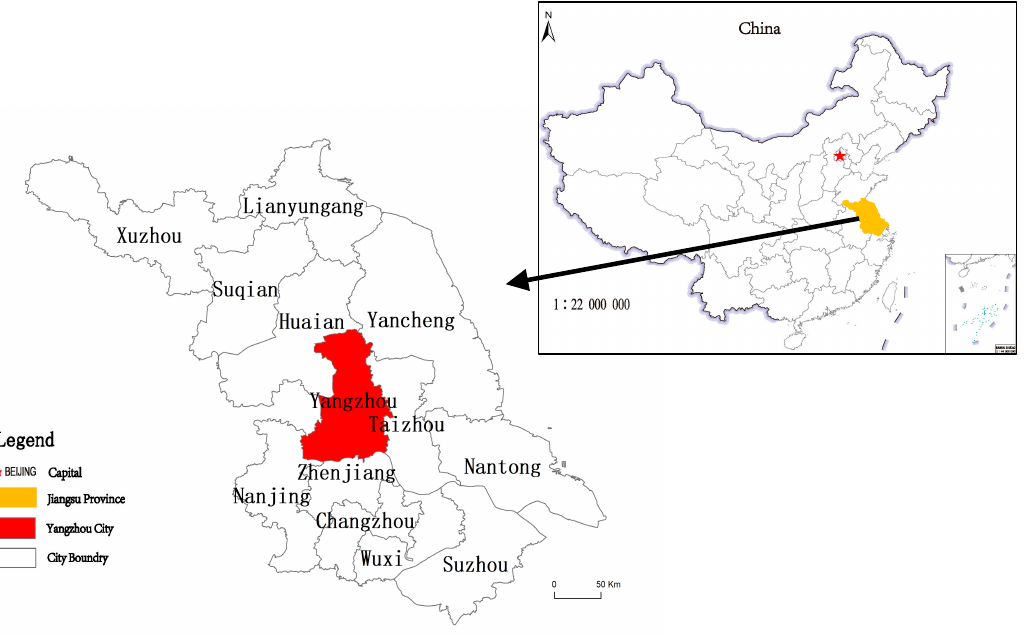
Figure 1. The location of the study area in China.